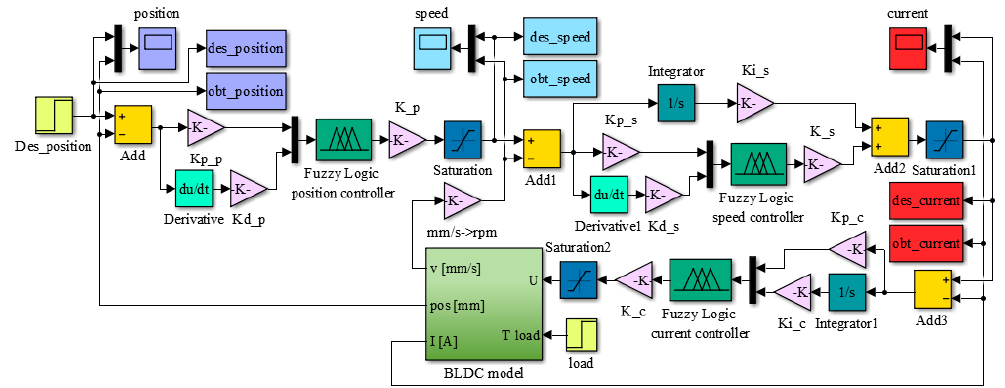
Figure 9. Matlab / Simulink model for the morphing actuator control Figure 9. Matlab/Simulink model for the morphing actuator control system.